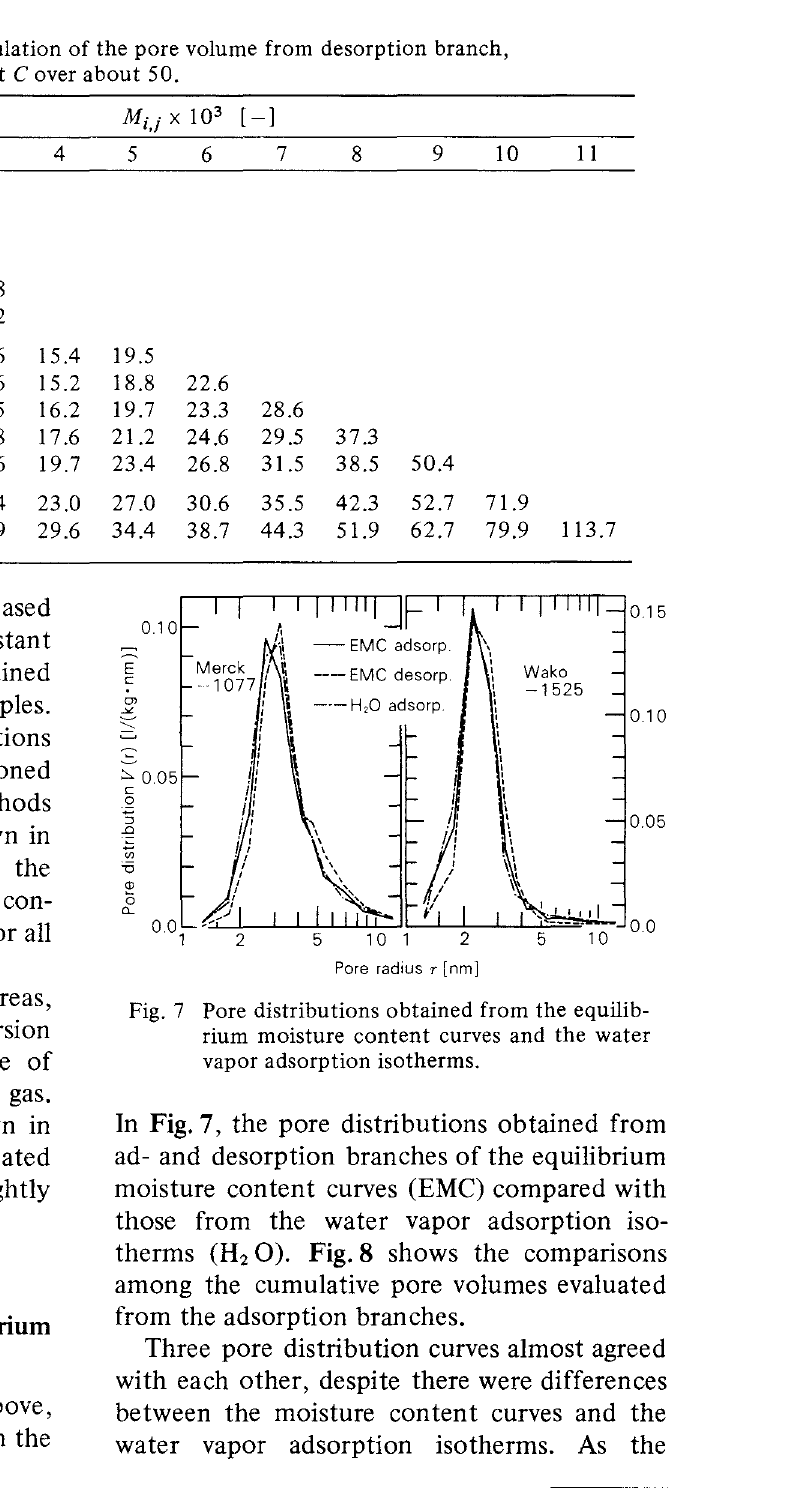
Table 3 Rc and M values for calculation of the pore volume from desorption branch, which has BET's constant Cover about 50.